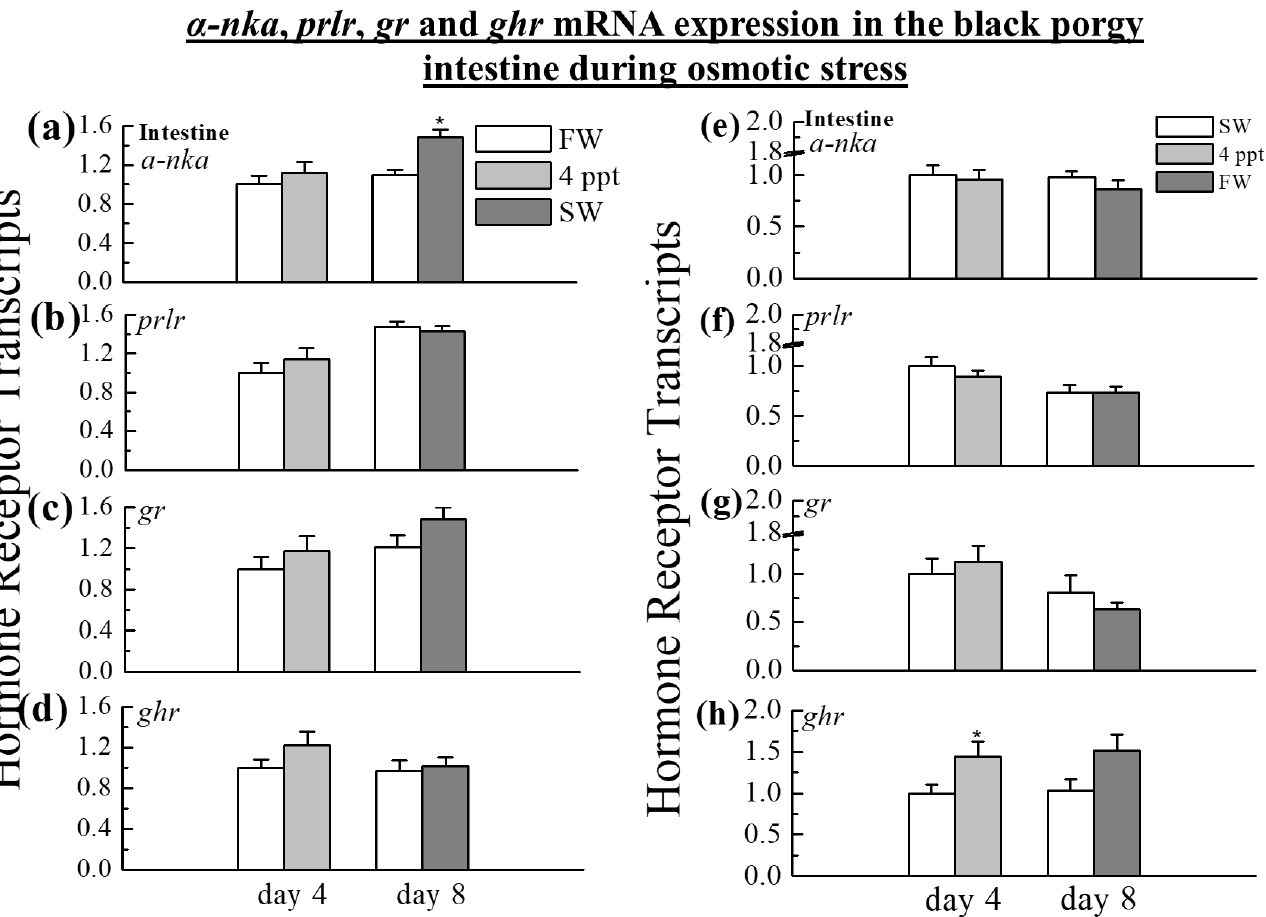
Figure 4. Q-PCR was performed to analyze the transcripts of α -nka , prlr , gr, and ghr in the intestine during the transfer of black porgy ( a – d ) from FW to 4 ppt and SW, and ( e – h ) from SW to 4 ppt and FW on day 4 and day 8. The relative gene expression was normalized to the control (FW or SW group) value on day 4. The results (n = 9) are expressed as the mean ± SEM. Asterisks (*) indicate significant differences ( p < 0.05) between the control and treated groups.